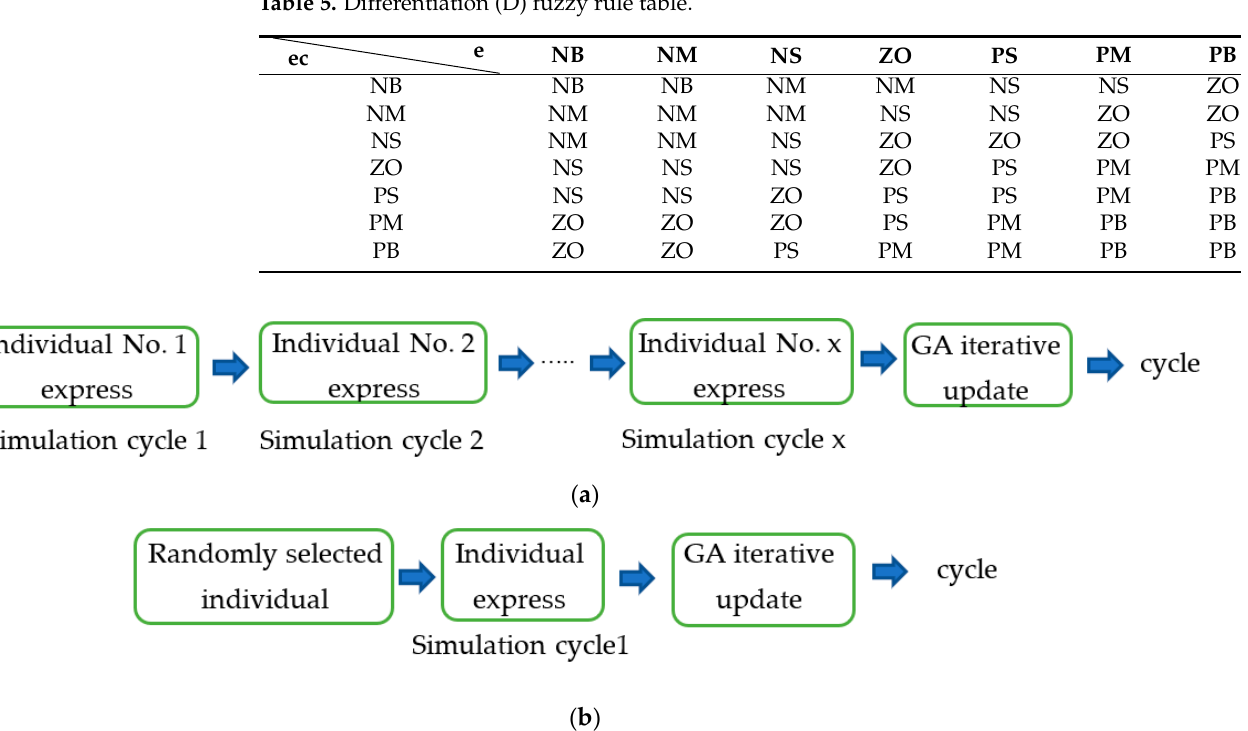
Table 5. Differentiation (D) fuzzy rule table.